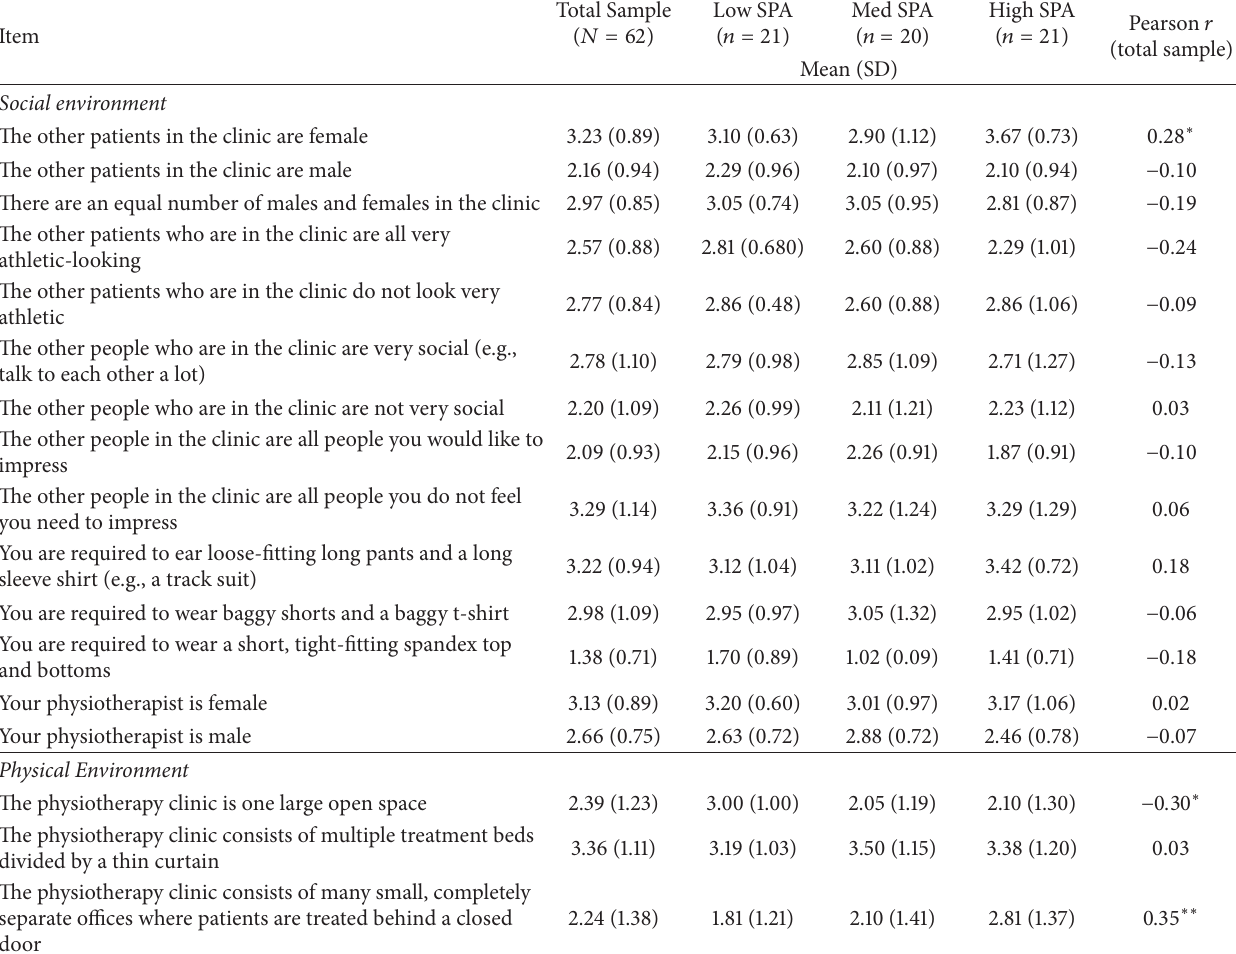
Table 6: Environmental preferences for injured participants and correlations with